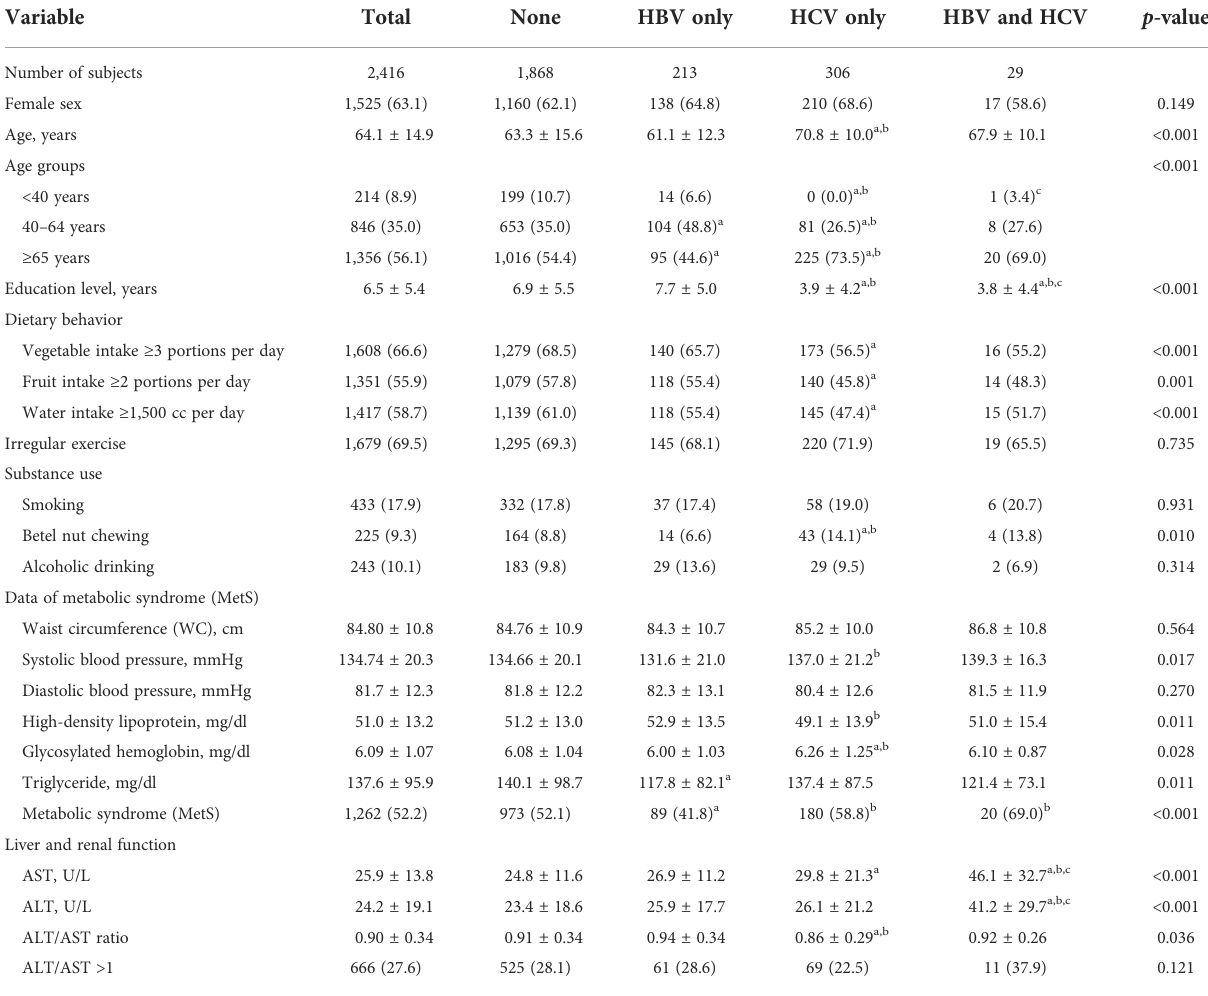
TABLE 1 Demographics and characteristics of the study subjects according to the HBV and HCV status ( N =